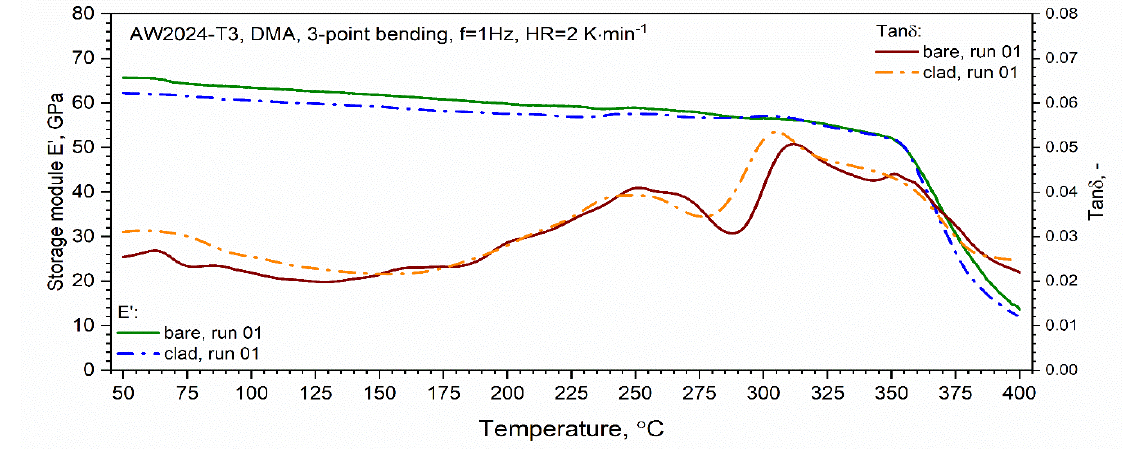
Figure 17. Dynamic storage modulus E ’ and tan δ (dynamic dumper factor) of bare and clad AW-2024-T3 (first heating).